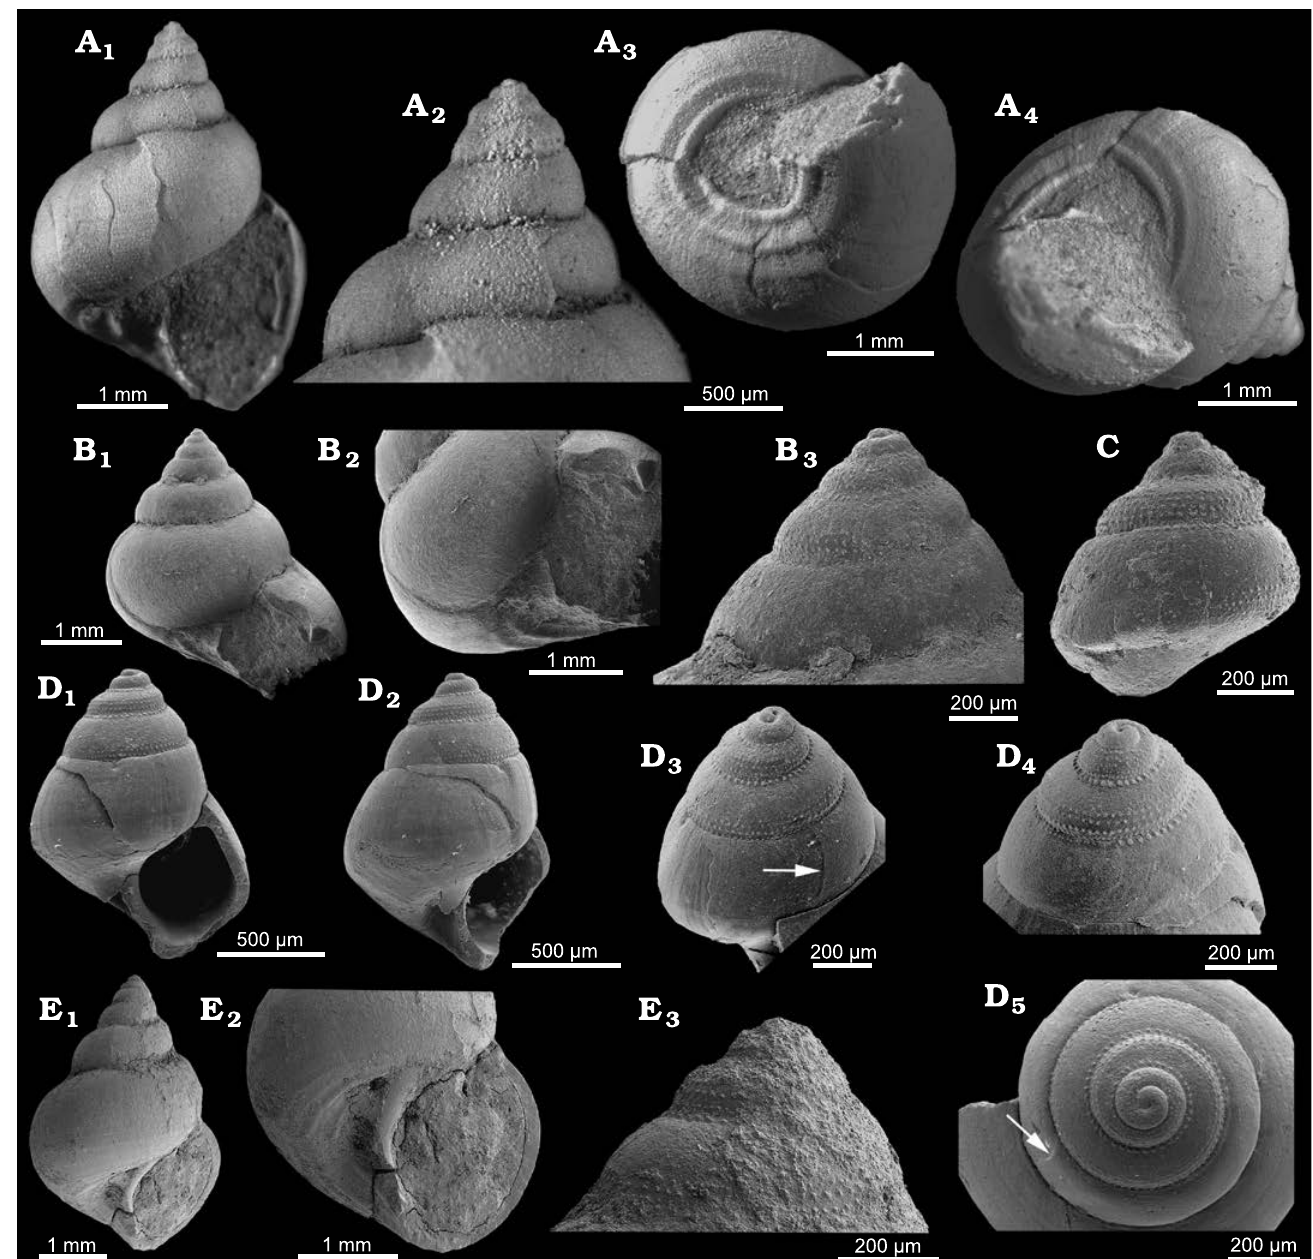
Fig. 13. Coelostylinid gastropods Helenostylina convexa (Nützel and Kaim, 2014) from Lago Antorno (A, B, C), Misurina Skilift (D), and Misurina Landslide (E), northern Italy, Cassian Formation, Carnian, Upper Triassic. A . PZO 12812, relatively large specimen with well-preserved base with spiral ribs, in apertural view (A 1 ); A 2 , early whorls in lateral view; A 3 , basal view showing spiral ribs; A 4 , oblique basal view showing spiral ribs on base. B . PZO 12813, relatively large specimen with spiral ribs on base and protoconch with tubercles, in apertural view (B 1 ); B 2 , close up of base showing spiral ribs on base; B 3 , early whorls with tubercles on larval shell, in lateral view. C . PZO 12814, juvenile shell with tubercles on larval shell, in lateral view. D . PZO 12694, juvenile shell with tubercles on larval shell and healed shell fracture, in apertural (D 1 ) and lateral (D 2 , D 4 ) views; details showing end of larval shell (arrows), in lateral (D 3 ) and apical (D 5 ) views. E . PZO 12695, relatively large specimen with well-preserved base with spiral ribs and protoconch with tubercles, in apertural view (E 1 ); E 2 , oblique apertural view to show base with spiral ribs; E 3 , protoconch in lateral